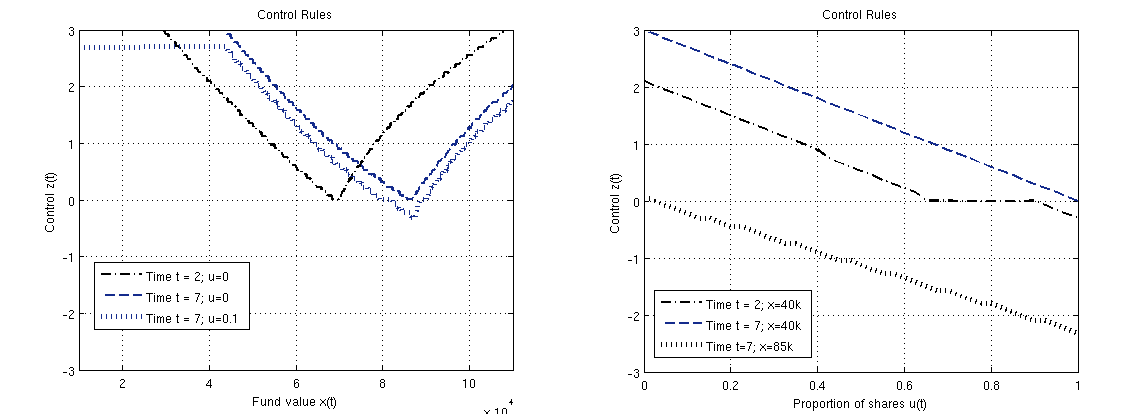
Figure 5. Control rules for t = 2 and t = 7 in x ( t ) (left panel) and u ( t ) (right panel) for b = 0 . 005